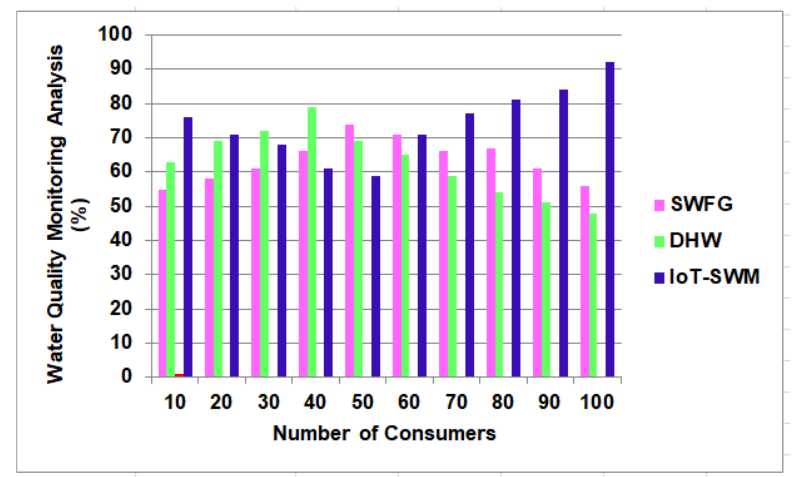
Figure 7. Water quality monitoring analysis.